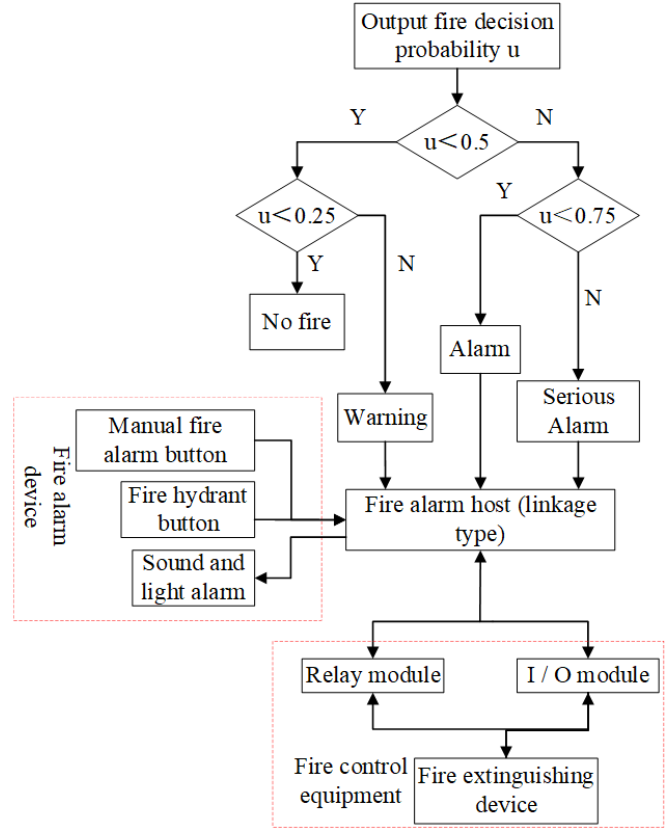
Figure 7. Flowchart of substation fire warning and fire control.